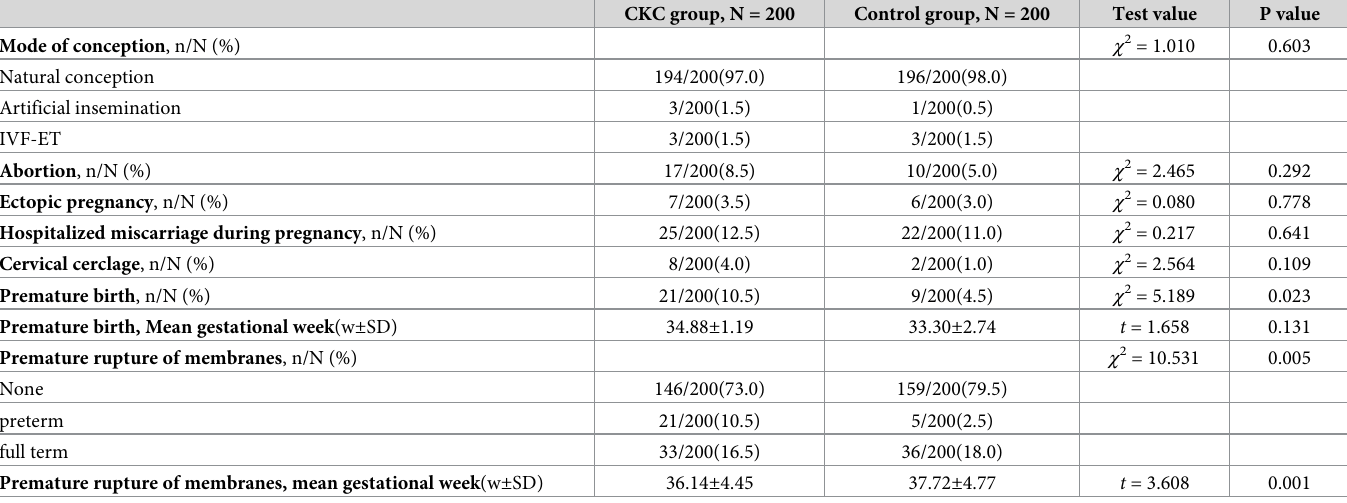
Table 2. Comparison of mode of conception and adverse pregnancy outcomes between the CKC group and the control